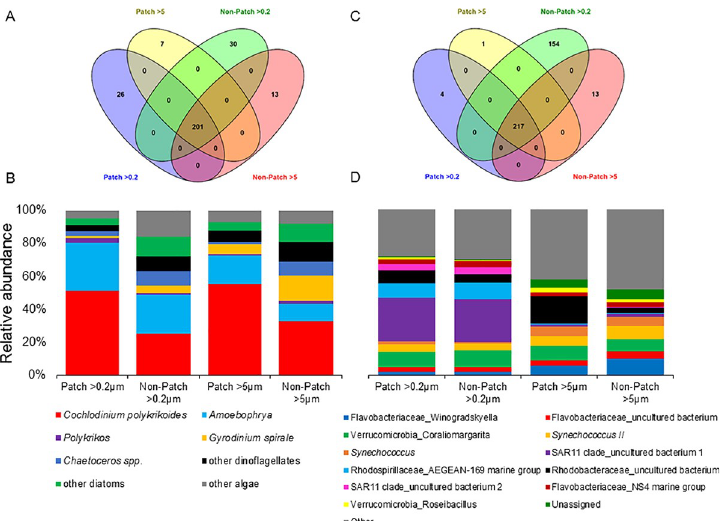
Fig 3. Venn diagrams demonstrating the shared and unique A) 18S OTUs-, C) 16S OTUs- and average abundances of corresponding B) 18S consensus lineages- and D) 16S consensus lineages- of the core microbiomes found among Patch > 0.2 and > 5, and Non-patch > 0.2 and > 5 micron size fractioned samples. Venn diagrams colors represent the following: patch > 0.2 (blue), patch > 5 (yellow), non-patch > 0.2 (green) and non-patch > 5 (red). Numbers within the diagrams represent number of